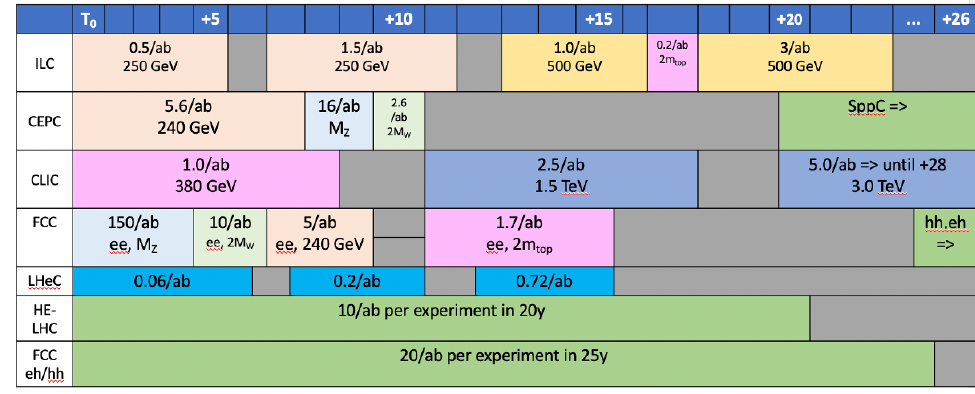
Figure 1 . Time line of various collider projects starting at time T 0 as submitted to the European Strategy Update process. Some possible extensions beyond these baseline run plans have been discussed and are presented in more detail in appendix F. For the clari(cid:12)cation of the meaning of a year of running, see the caption of table 1. Figure 13 in appendix C shows an alternative version of this (cid:12)gure using the earliest possible start date (i.e. the calendar date of T 0 ) given by the